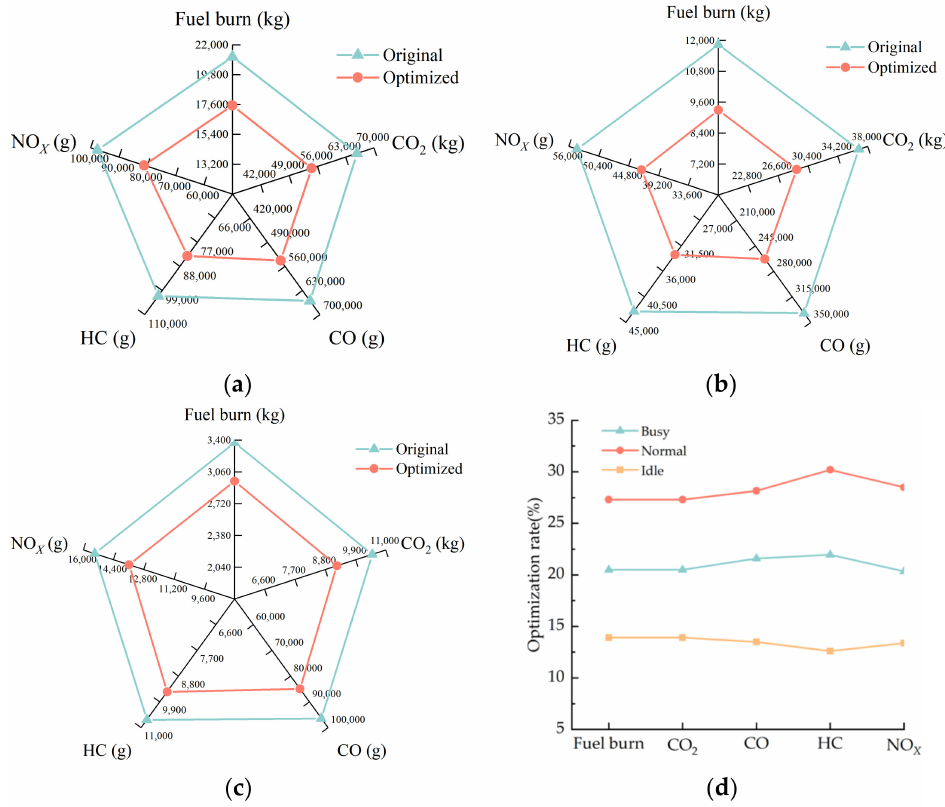
Figure 9. ( a ) Comparison of fuel burn, emissions of CO 2 , CO, HC, and NO X before and after optimization under Peak scenario; ( b ) Comparison of fuel burn, emissions of CO 2 , CO, HC, and NO X before and after optimization under Normal scenario; ( c ) Comparison of fuel burn, emissions of CO 2 , CO, HC, and NO X before and after optimization under Idle scenario; ( d ) Optimization rate of fuel burn, emissions of CO 2 , CO, HC, and NO X